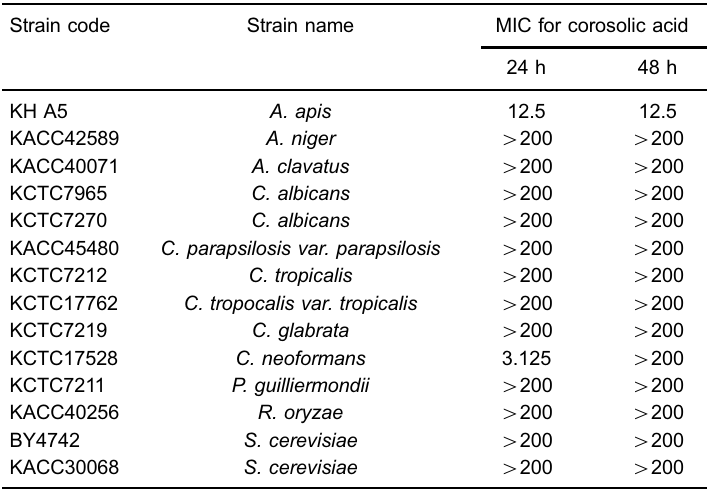
Table 3 . In vitro susceptibility of fungi to corosolic acid at 24 and 48 h. Strain